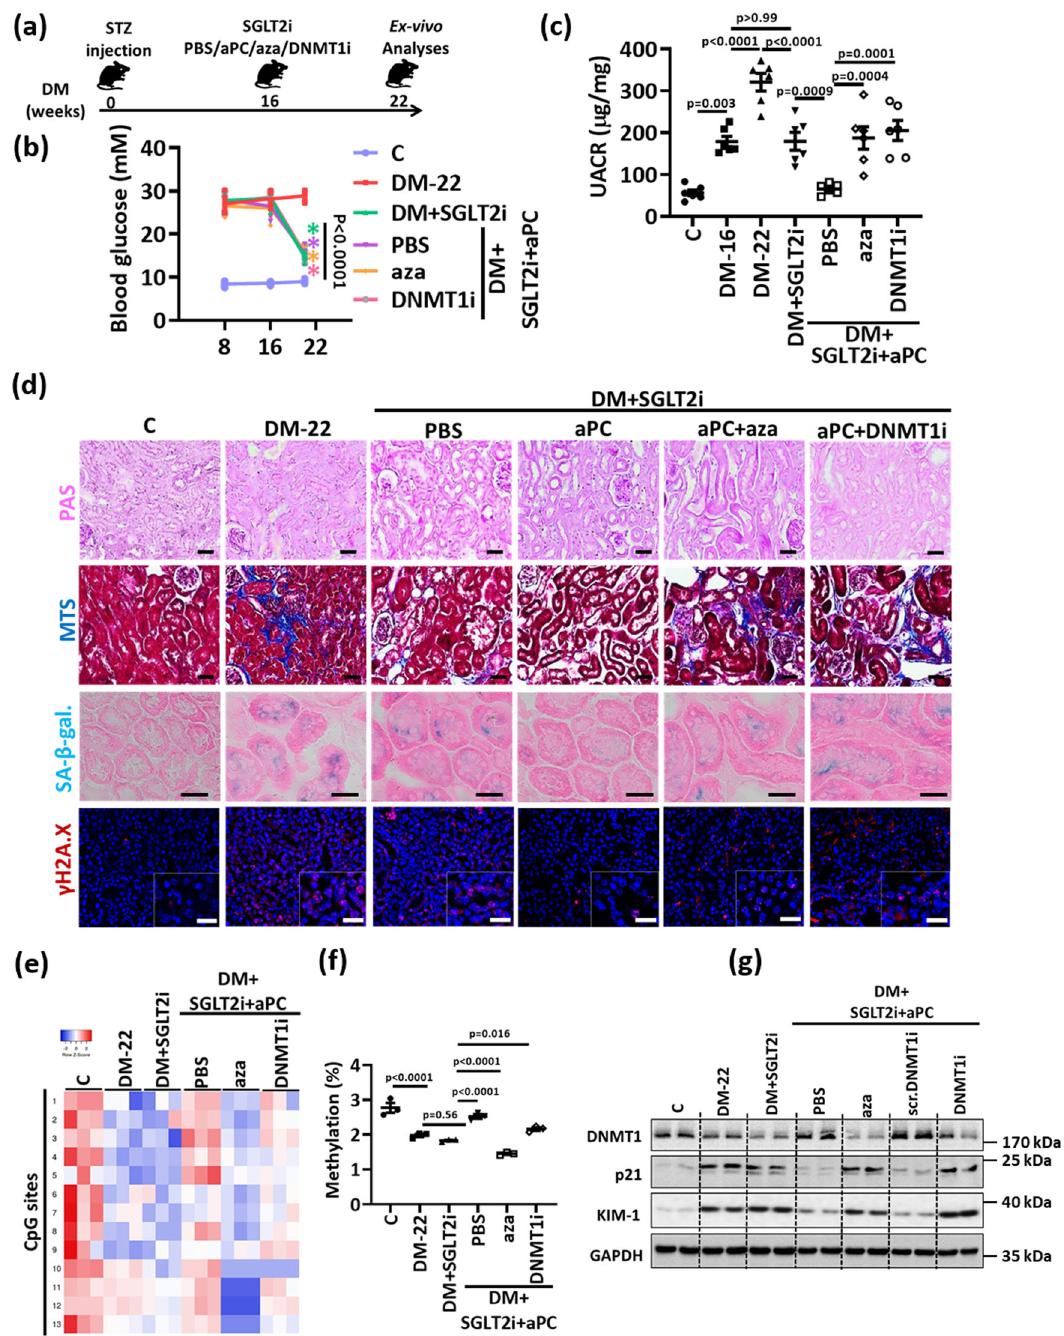
Fig. 7 | aPC reverses epigenetically sustained renal p21 expression and tubular senescence. a Experimental scheme: 16 weeks after induction of persistent hyperglycemia, diabetic mice were treated with PBS (DM-22), sodium/glucose cotransporter 2-inhibitor (Dapagli fl ozin ® , DM+SGLT2i), a combination of SGLT2i and aPC (DM+SGLT2i+aPC), a combination of SGLT2i, aPC and the pan DNMTs- inhibitor 5-aza-deoxycytidine (DM+SGLT2i+aPC+aza), or a combination of SGLT2i, aPC and a vivo morpholino targeting DNMT1 (DM+SGLT2i-aPC-DNMT1i) for further 6 weeks. b Average blood glucose levels in experimental groups (as described in a) after 8 or 16 weeks of persistent hyperglycemia and at 22 weeks. c Dotplot summarizing albuminuria(urinaryalbumin-creatinine ratio, µ g albumin/ mg creatinine; UACR) in experimental groups (as described in a ). Baseline albu- minuriabeforeinterventionswasdeterminedafter16weeksofhyperglycemia(DM- 16). d ExemplaryhistologicalimagesofperiodicacidSchiffstains (PAS), interstitial fi brosis (Masson ’ s trichrome stain, MTS), SA- β -gal. stain (senescence associated β -